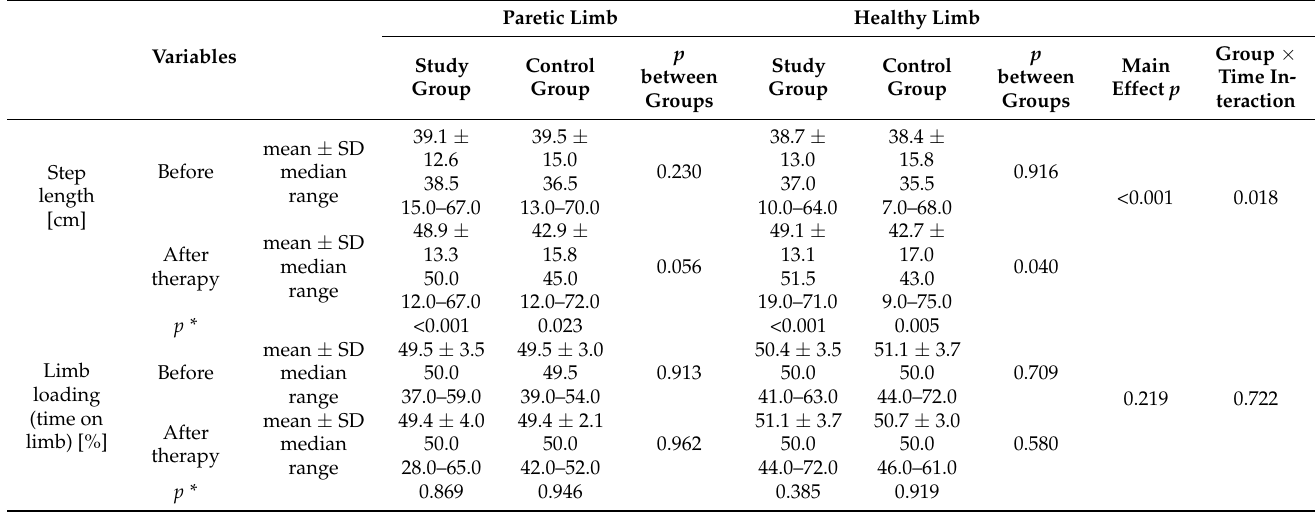
Table 2. Step length and limb loading results for study and control groups before and after the therapy.